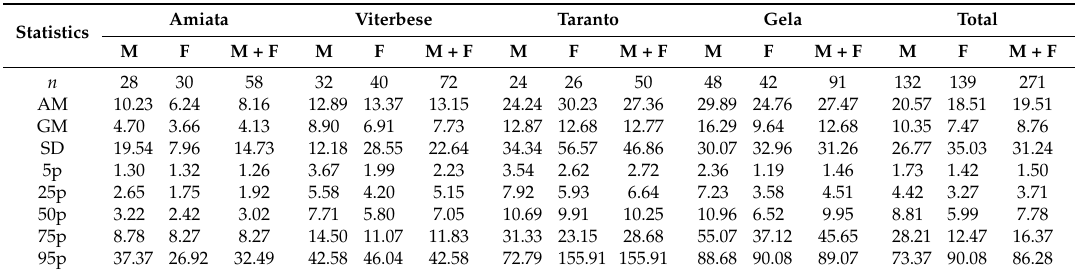
Table 2. Descriptive analysis on u(iAs+MMA+DMA) ( µ g/L) by area and